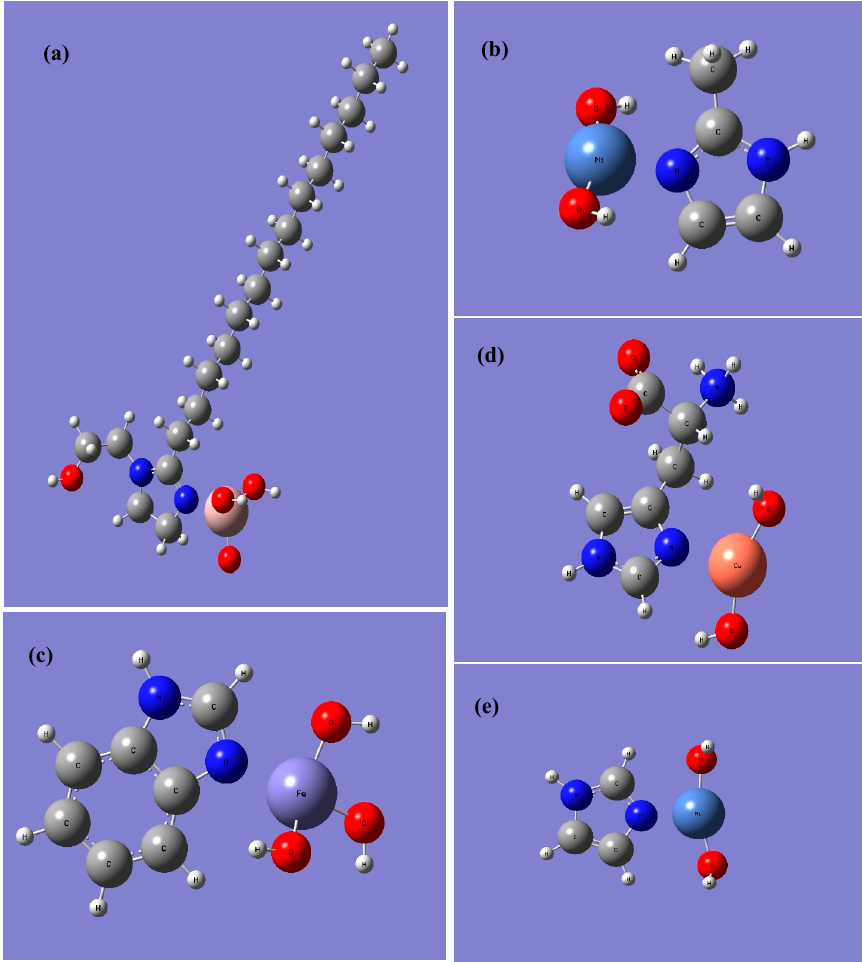
Figure 2. Binding Modes of different inhibitors onto different metal hydroxides ( a ) optimized structure of IMZ_C14: Al(OH) 3 ; ( b ) optimized structure of Me-IMZ: Ni(OH) 2 ; ( c ) optimized structure of BI: Fe(OH) 3 ; ( d ) optimized structure of L -HIS: Cu(OH) 2 ; ( e ) optimized structure of IMZ: Ni(OH) 2 .